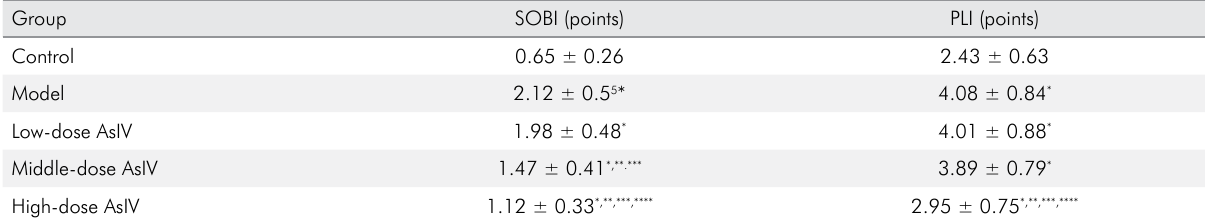
Table 2. SOBI and PLI in different groups after treatment.